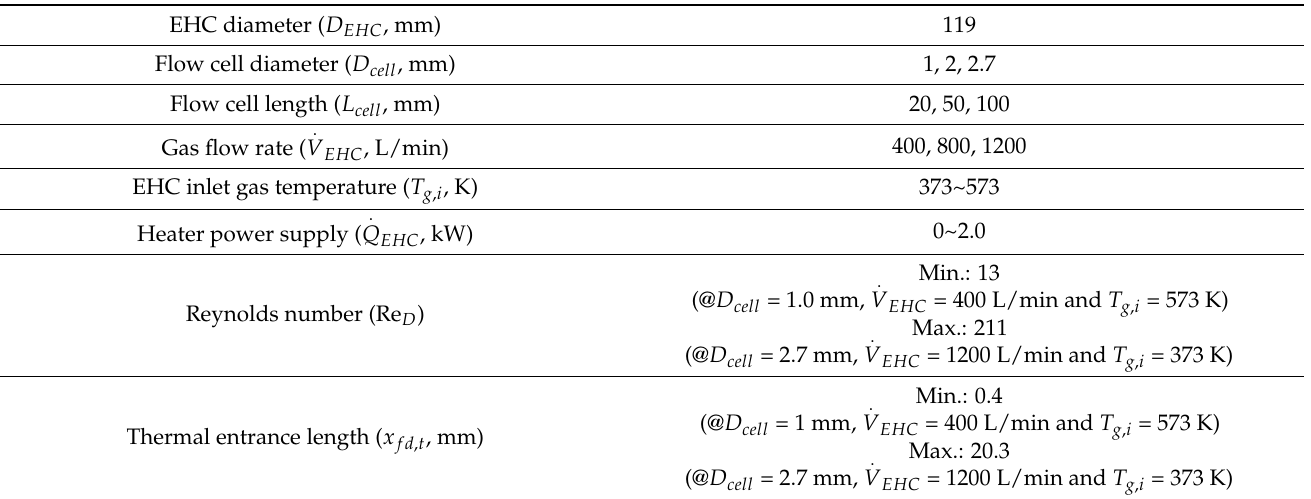
Table 1. Analysis